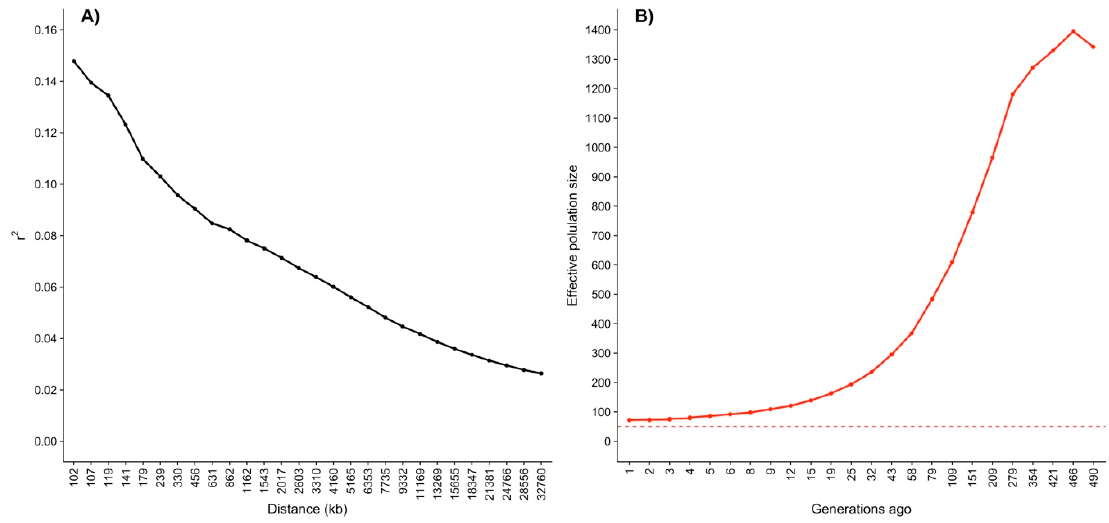
Figure 5. ( A ) Linkage disequilibrium estimated through the correlation between pairs of loci ( r 2 ) over distances between markers; ( B ) effective population size trend from 1 to 490 generations ago, the dashed line represents the threshold of 50 proposed as the minimal values to maintain genetic diversity in acceptable levels.